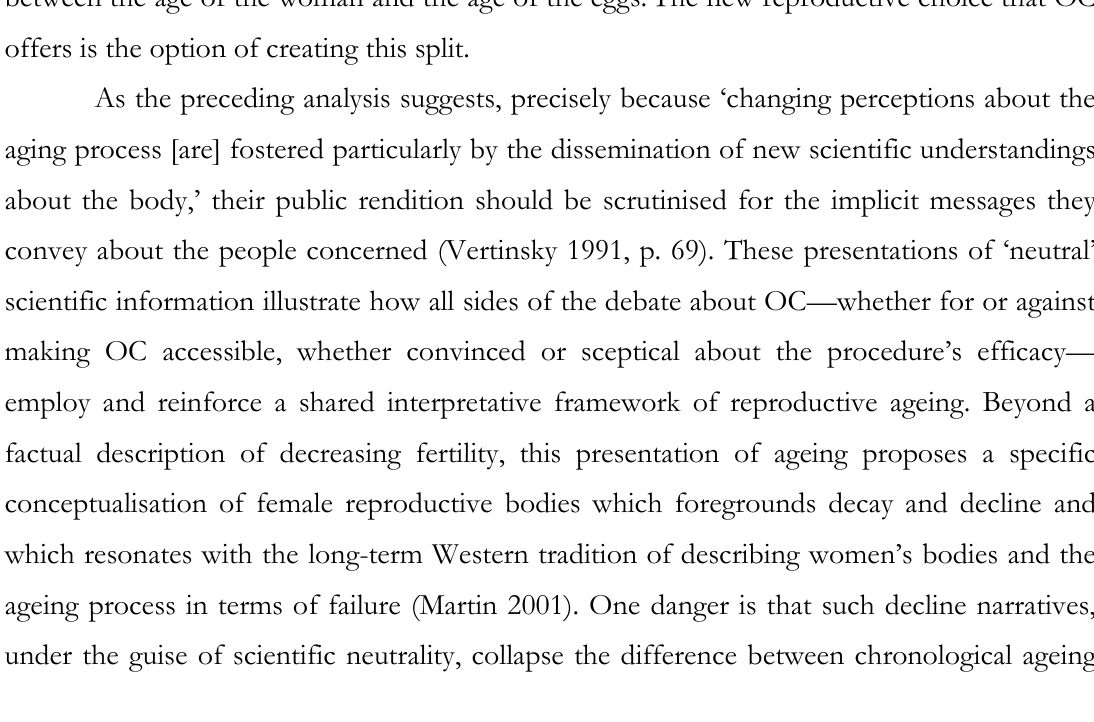
Lucy van de Wiel, For Whom The Clock Ticks: Reproductive Ageing and Egg Freezing in Dutch and British News